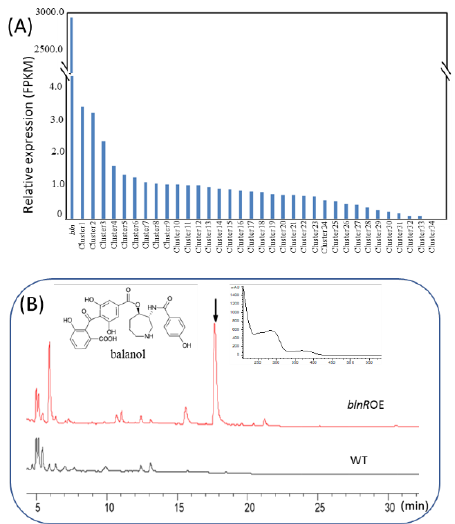
Figure 3. Affinity binding analysis of BlnR with promoter DNA through EMSA experiment. ( A ) Schematic diagram of promoter design in the bln gene cluster . ( B ) Heterologous expression of BlnR in E. coli. M: protein marker. ( C ) Affinity binding analysis of BlnR to gene promoters within bln by EMSA. ( D ) The conserved binding motif of BlnR was predicted by MEME analysis. 3.3. BlnR Is a Positive Regulator toward Balanol Biosynthesis in T. ophioglossoides